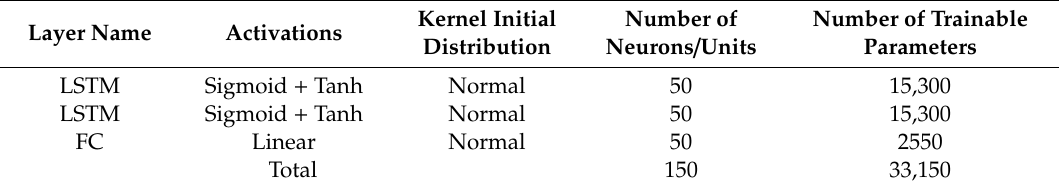
Table 2. GRU model hyperparameters.